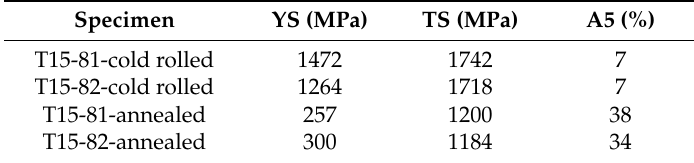
Table 4. Mechanical properties of sheets T15-81 and T15-82 in cold rolled and annealed state.